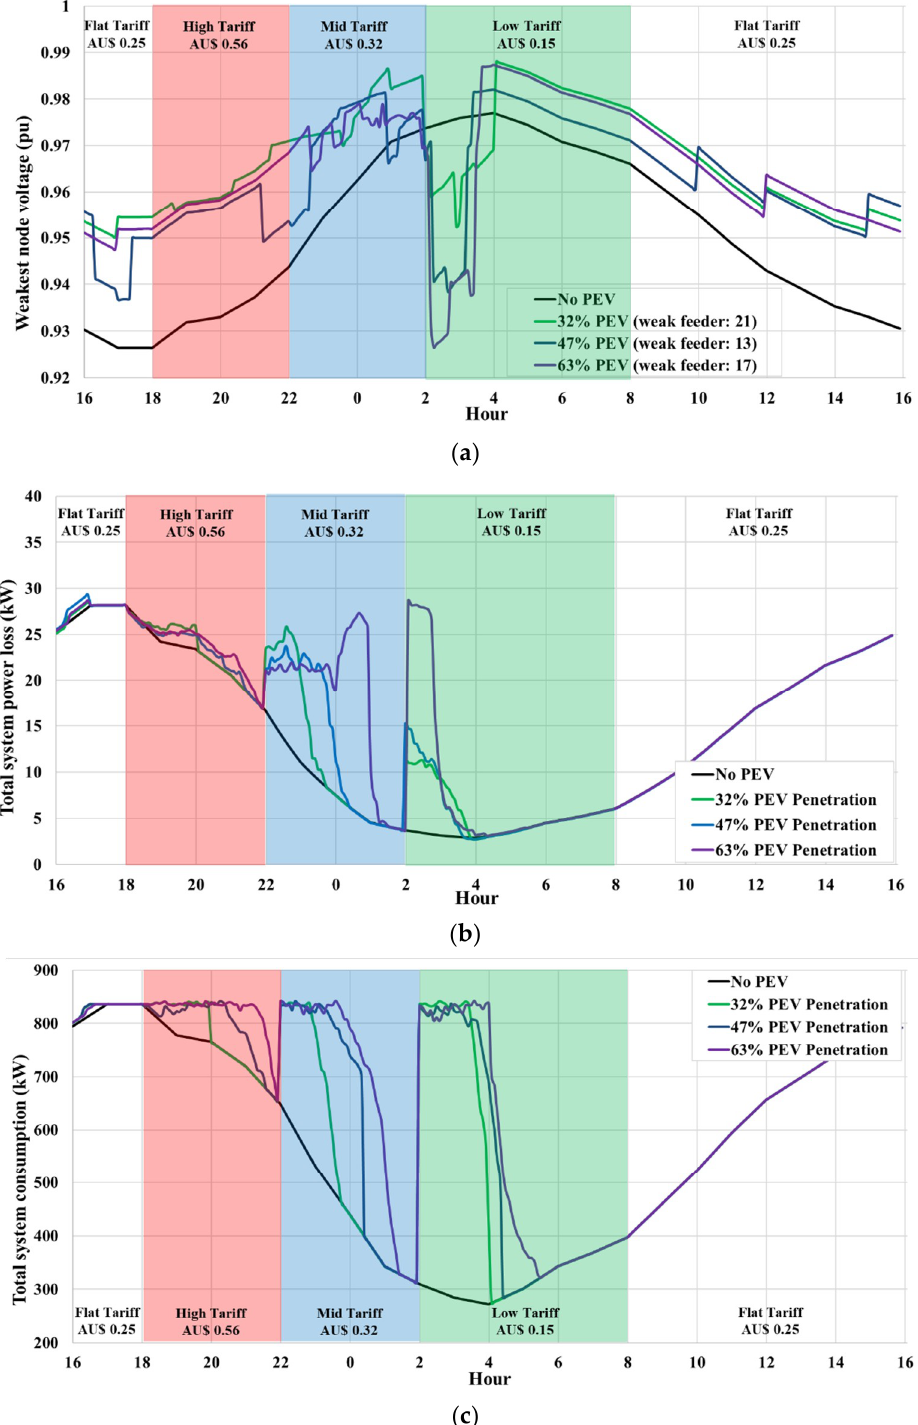
Figure 8. Voltage profile, ( b ) total power loss, and ( c ) total power consumption employing the ToU electrical tariff for cost minimization.